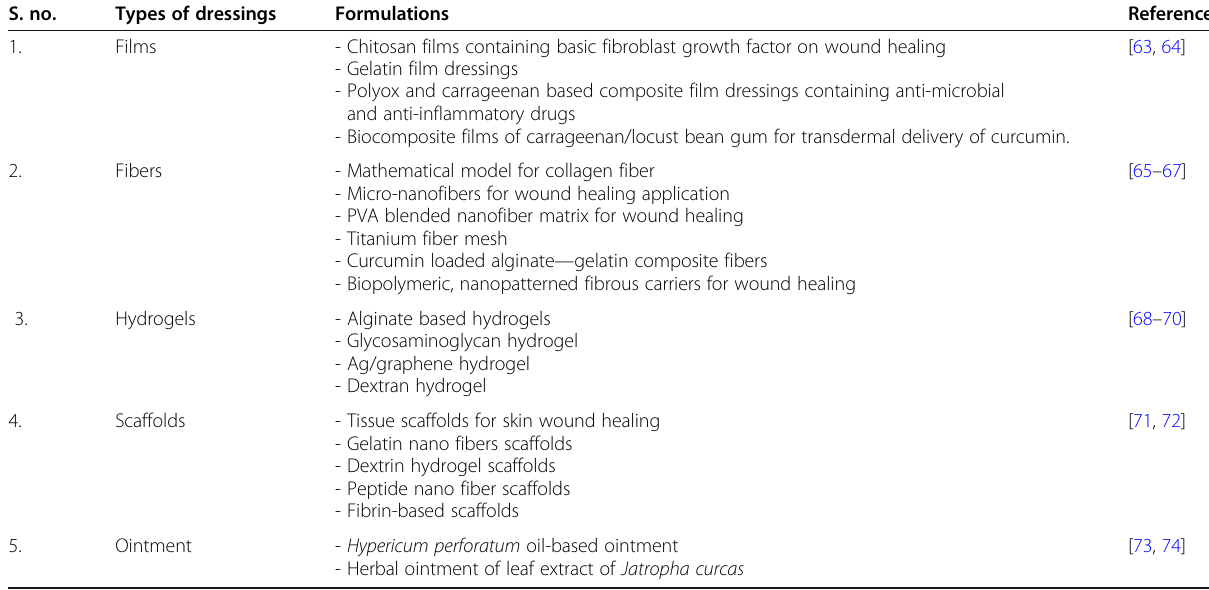
Table 2 Different types of wound dressings for the delivery of plant-based constituents S.